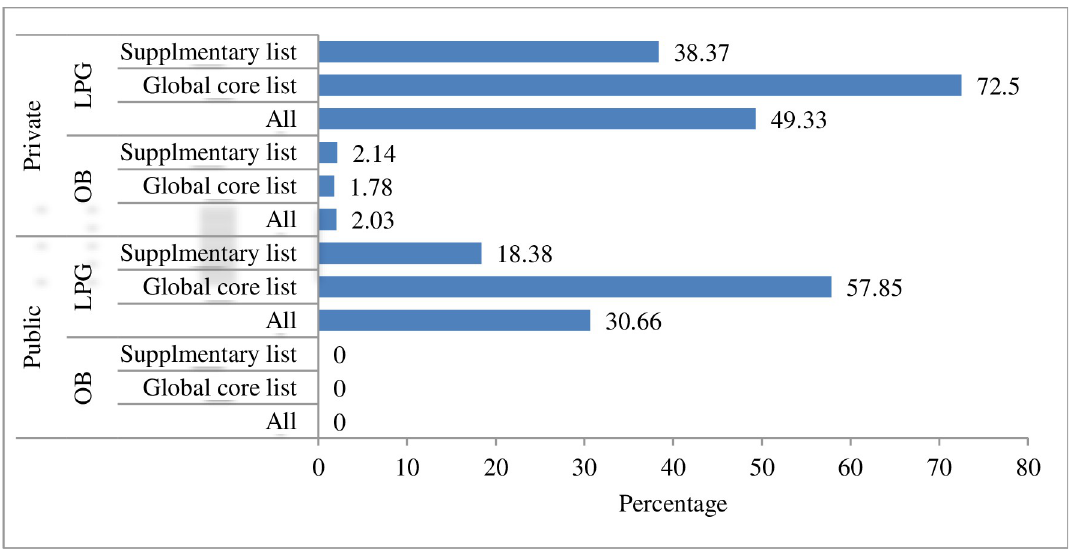
Fig 1. Period availability of OB and LPG medicines in health facilities of Dessie town,